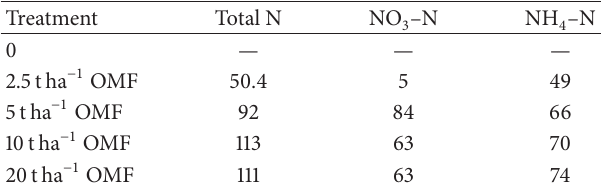
Table 1: Percentage increase in forms of nitrogen.